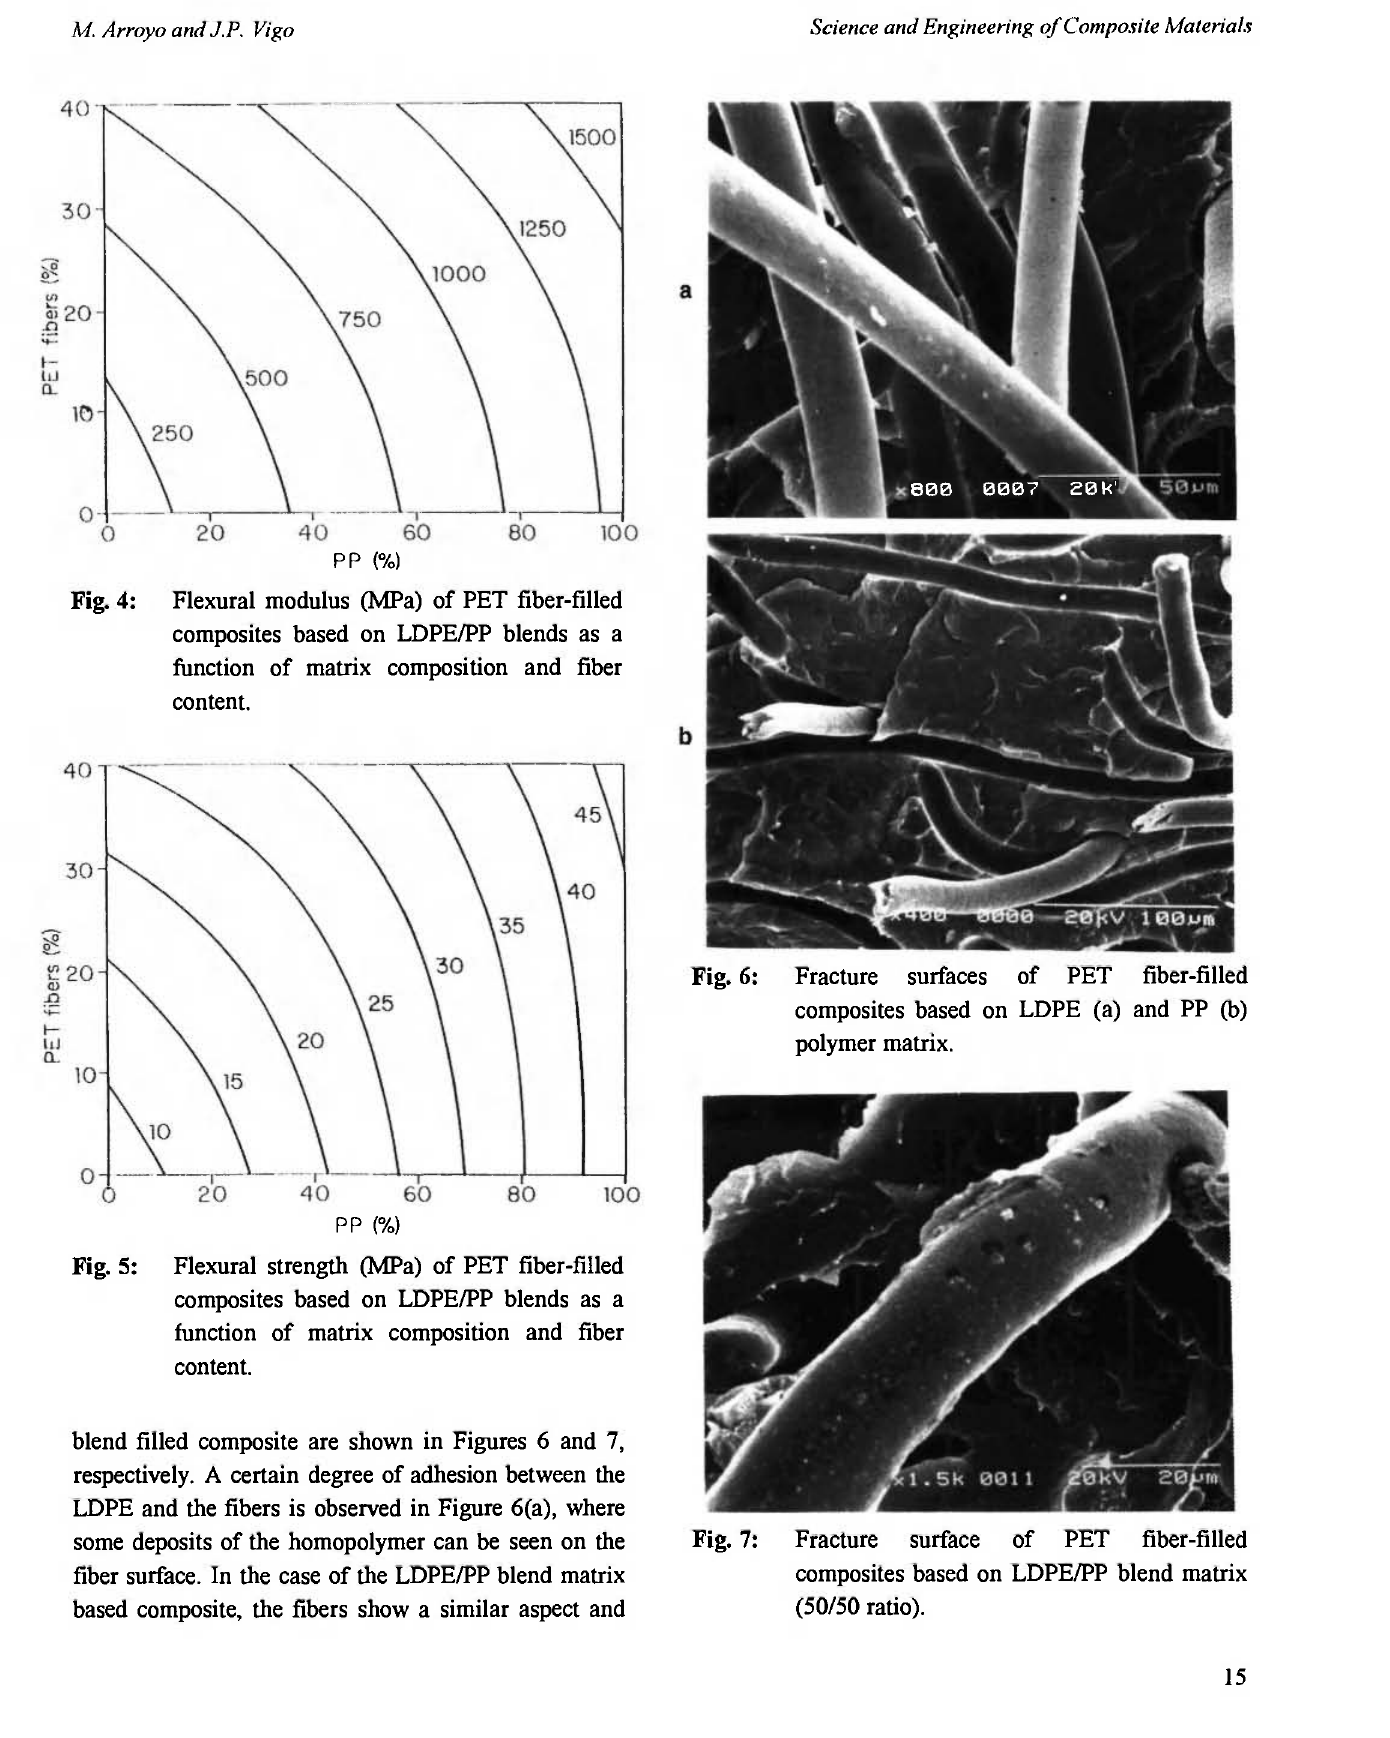
Fig. 7: Fracture surface of PET fiber-filled composites based on LDPE/PP blend matrix (50/50 ratio).